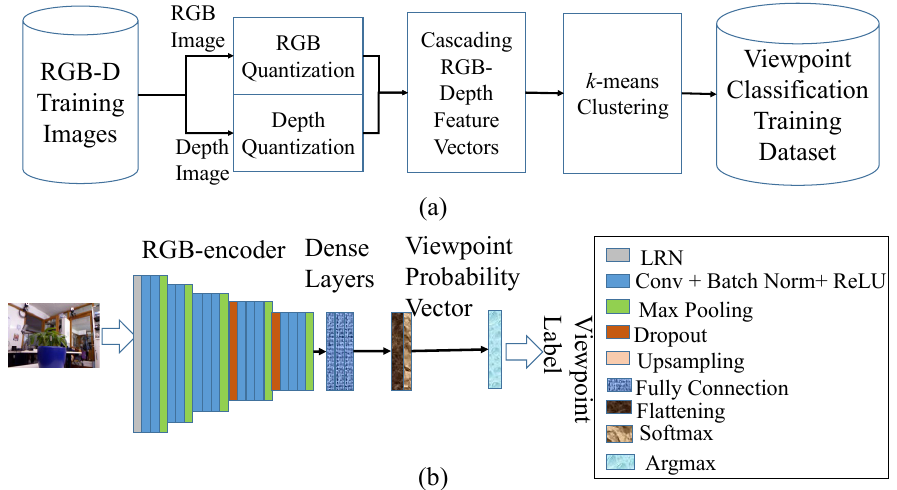
Figure 5. The proposed deep viewpoint classification neural network (DVCNN): ( a ) the block diagram of generating the training dataset for viewpoint classification learning; ( b ) the deep architecture of the DVCNN.